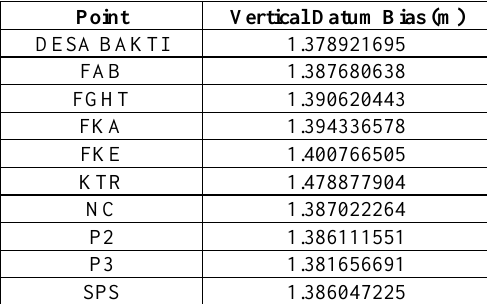
Figure 8. Contour map of UTM Fitted